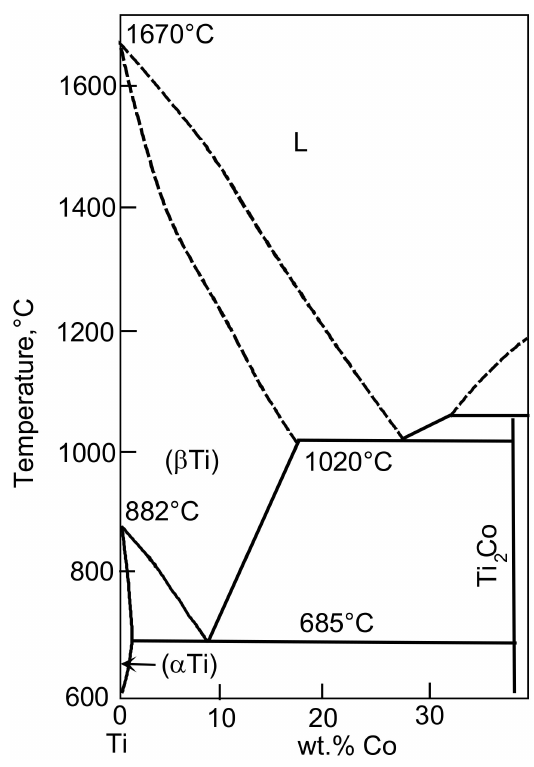
Figure 1. The Co-rich part of the Ti–Co phase diagram